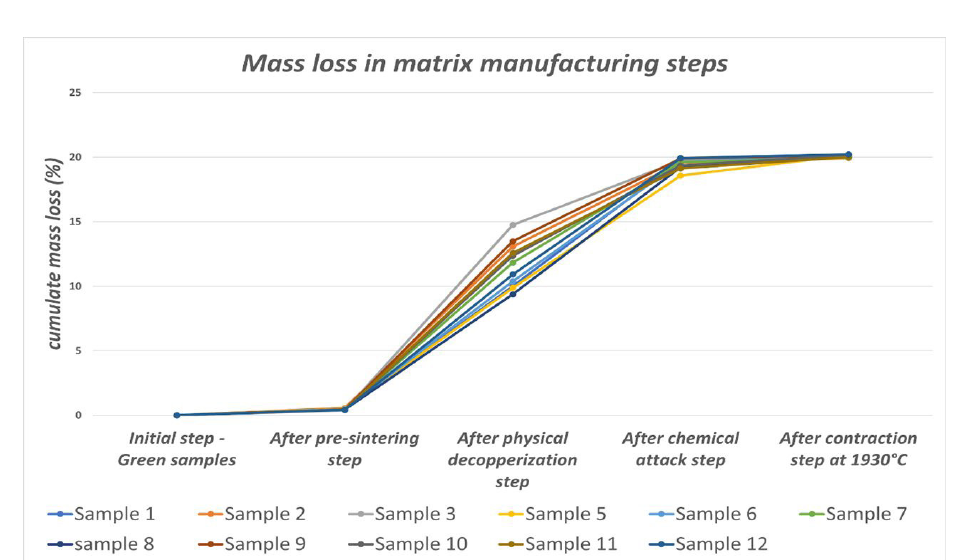
Figure 7. Cumulate mass losses along matrix manufacturing